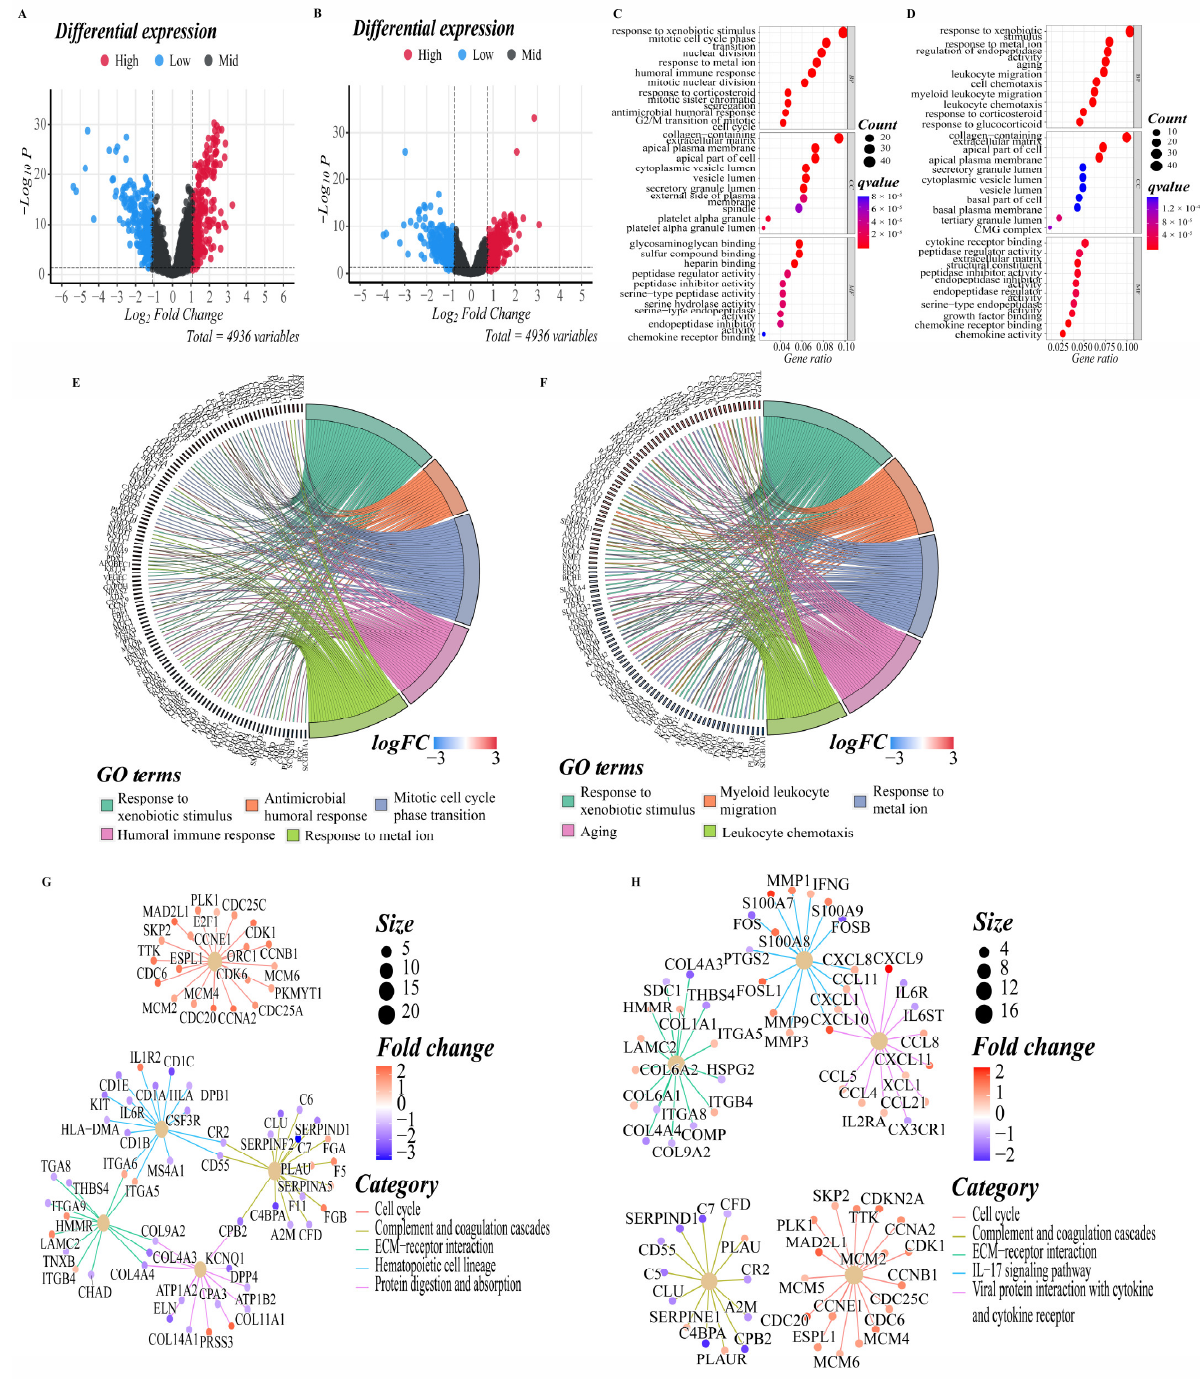
Figure 5. DEGs functional enrichment analysis between high and low-risk groups. ( A , B ) The volcano map depicts the distribution of downregulated and upregulated DEGs in the two cohorts’ high-risk and low-risk groups (( A ): training cohort; ( B ): validation cohort). ( C , D ) The point diagram shows the top ten GO terms of each subclass (BP, biological processes; MF, molecular function; CC, cellular component) (( C ): training cohort; ( D ): validation cohort). ( E , F ) The chord plot shows the genes of the top five GO terms of the BP sub-class (( E ): training cohort; ( F ): validation cohort). ( G , H ) The network diagram shows the expression relationship of genes in the top five pathways of KEGG pathway analyses. Fold enrichment of each term is indicated by the x-axis and bar color. (( G ): training cohort; ( H ): validation